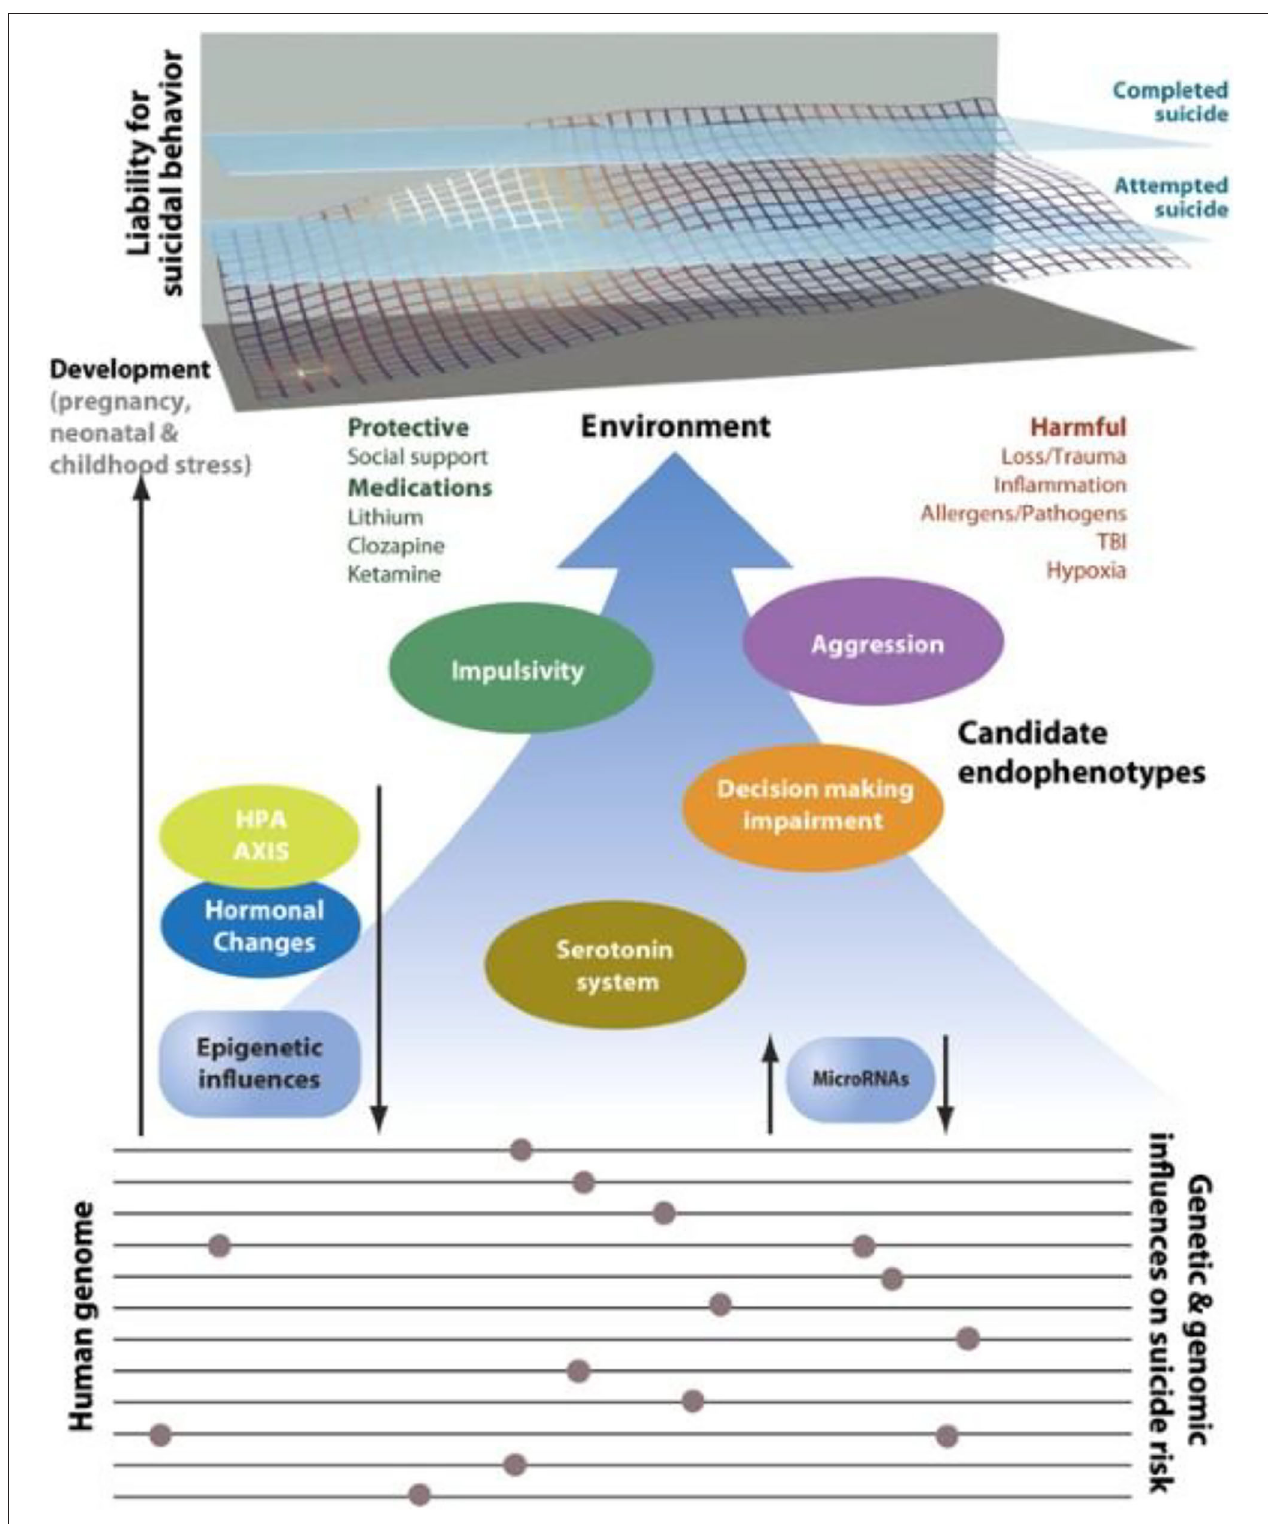
FIGURE 1 | Intermediate phenotypes for suicidal behavior. Model displaying candidate genes, endophenotypes, and environmental risk factors implicated in suicidal behavior that may lend themselves to further study in animal model systems. The upper portion shows the cumulative liability for suicide originating in the